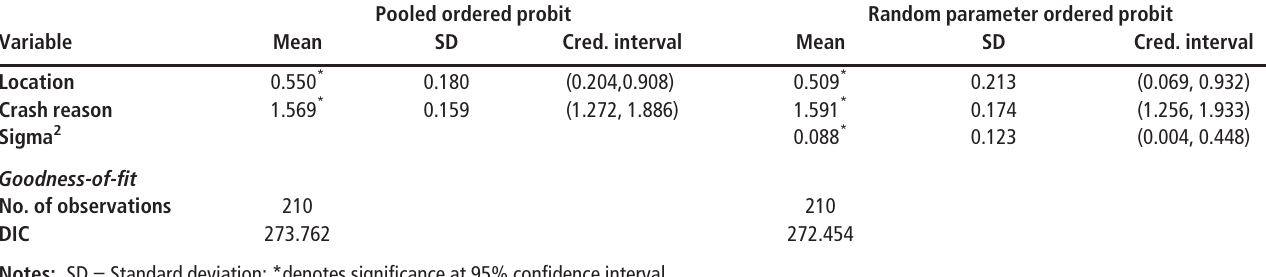
Table 3 Liability results for Bayesian pooled ordered probit and Bayesian random parameter ordered probit